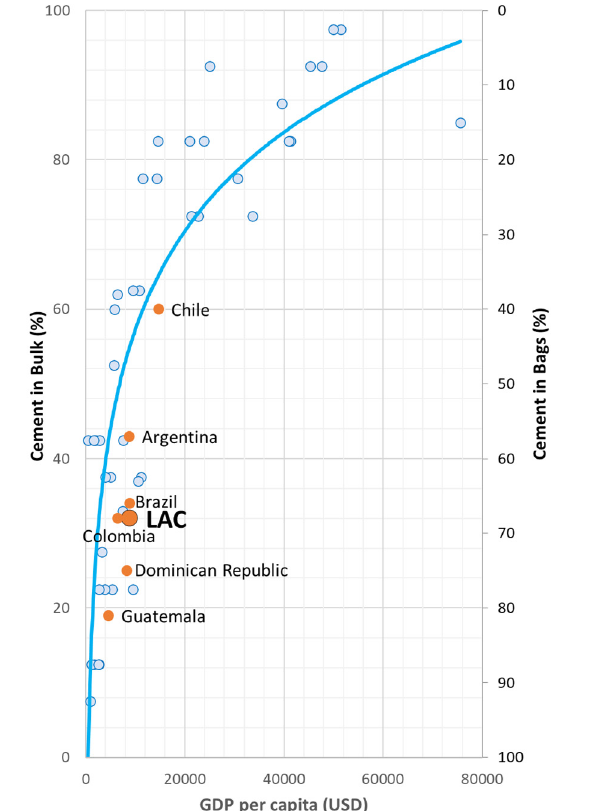
Figure 2. Market share of bagged cement in various regions and key countries with their GDP per capita (adapted from